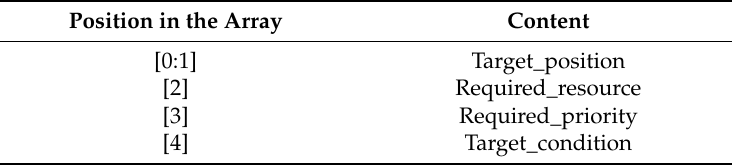
Table 1. Attributes of target model.